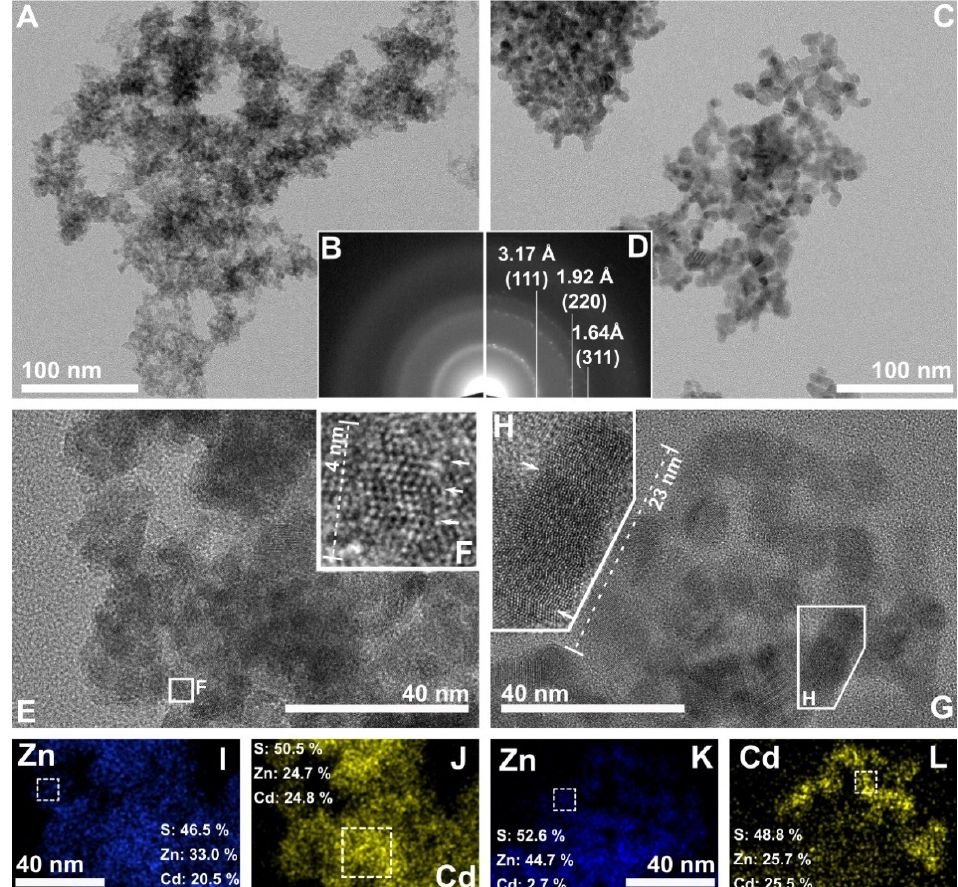
Figure 9. TEM/STEM results obtained from the Cat-1N-0H sample ( left column , ( A , B , E , F , I , J ) images) and its heat-treated pair Cat-1N ( right column , ( C , D , G , H , K , L ) images). The compositional inhomogeneity of crystallites expected on the basis of SEM/EDS images is less obvious. The STEM EDS Zn (blue) and Cd (yellow) elemental maps were measured on the same areas as the HRTEM images (Figure 9E,G) and illustrate the inhomogeneity of the chemical compositions, as also indicated by the compositions calculated from the marked areas. For both catalysts, the Zn:Cd ratio varied over a wide range. Compared to the theoretical Zn:Cd ratio of 3:1, significant deviations in both direc- tions were observed, but neither pure CdS, nor pure ZnS were detected in the STEM-EDS element maps. The nanocrystals with the highest Cd content had Zn:Cd ratios of around 1 (Figure 9J,L), whereas the most Zn-rich nanocrystals had at least 6–10% Cd content (Fig- ure 9I,K). The elemental distribution within a given crystallite appeared to be uniform.